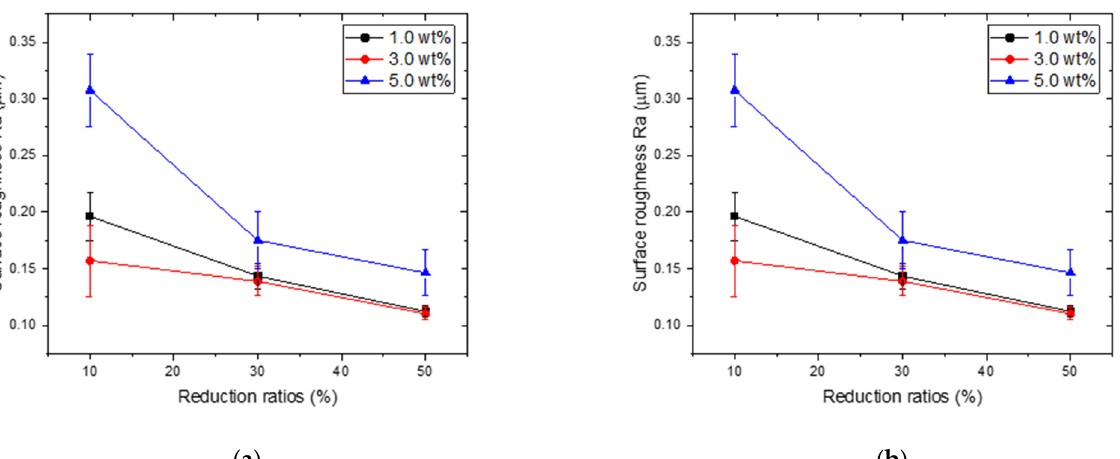
Figure 6. Reduction in the rolling forces of the rolled copper foils under different reduction ratios.